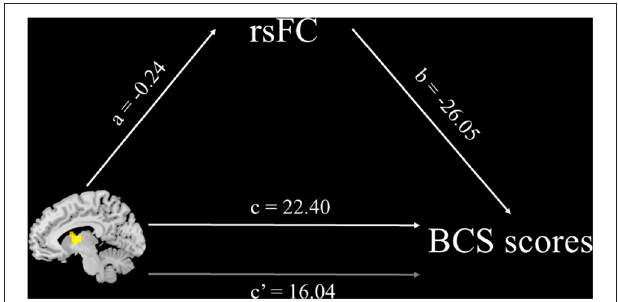
FIGURE 4 | Mediation analysis. Path c is the total effect of ReHo in the left thalamus on BCS scores; path c ′ is the direct effect of ReHo in the left thalamus on BCS scores after controlling for rsFC values of the thalamus–precuneus connection; the product of paths a and b (ab) is the indirect effect of ReHo in the left thalamus through rsFC values of the thalamus–precuneus connection on BCS scores. The standardized path coefficients are displayed on the path lines. Mediation analysis suggests that rsFC between the thalamus and the precuneus can account for the relationship between ReHo in the left thalamus and BCS scores.